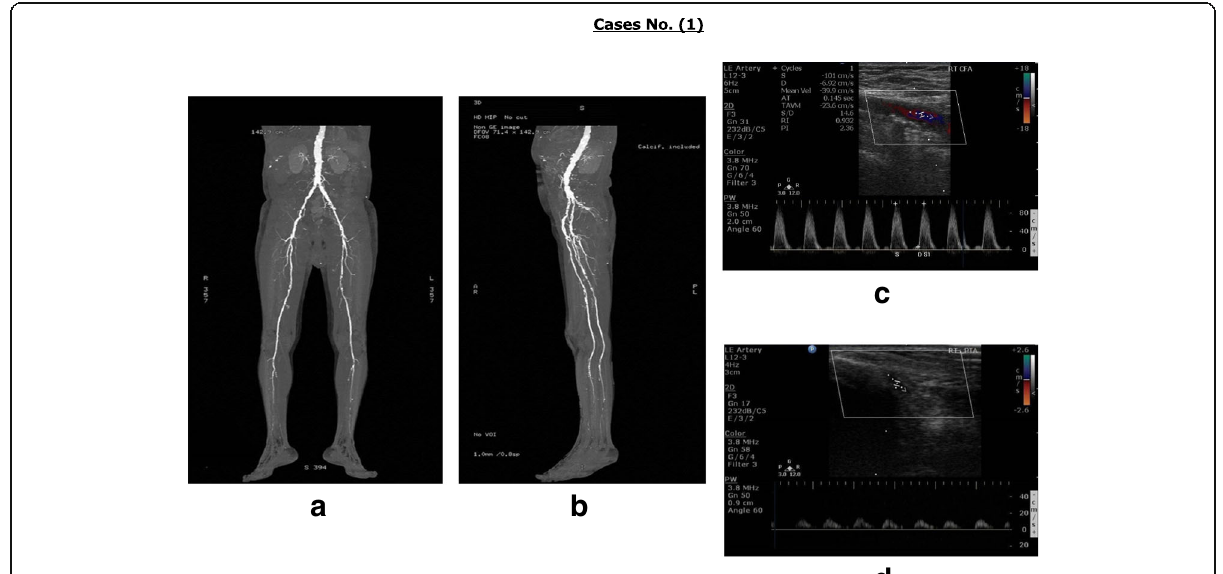
Fig. 1 Male patient aged 69 years, diabetic, smoker, not hypertensive, or cardiac. Color Doppler shows similar data with PSVst 100 cm/s and PSVdist 17 cm/s (PSVst/PSVdist < 1). a Bilateral severe atherosclerotic changes with diffuse bilateral multiple athermanous plaques with attenuated CIA, EIA, CFA, and SFA at both sides below 50% stenosis then retained accepted opacification of POP A then attenuation of the below-knee arteries. b Lateral view obviously shows the atherosclerotic stenosis of EIA, CFA, and SFA at both sides with attenuated PTA and ATA after a short segment of their origin with nearly non-opacified distal parts especially the ATA. c Multiple athermanous plaques in the Rt CFA with below